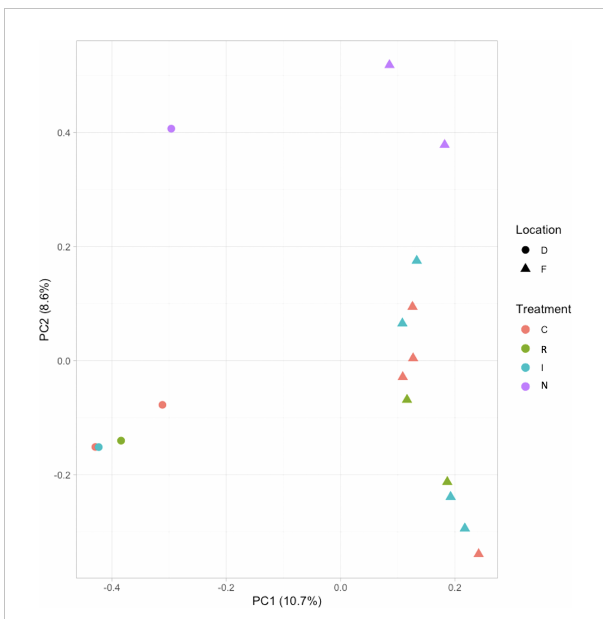
FIGURE 11 Principal component analysis (PCA) of the SNPs of the 17 samples from Fiñana and Dornajo